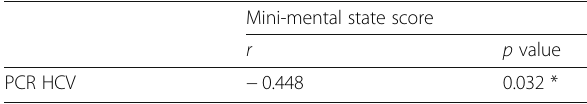
Table 5 Mini-mental state score and basal ganglia metabolites in the study